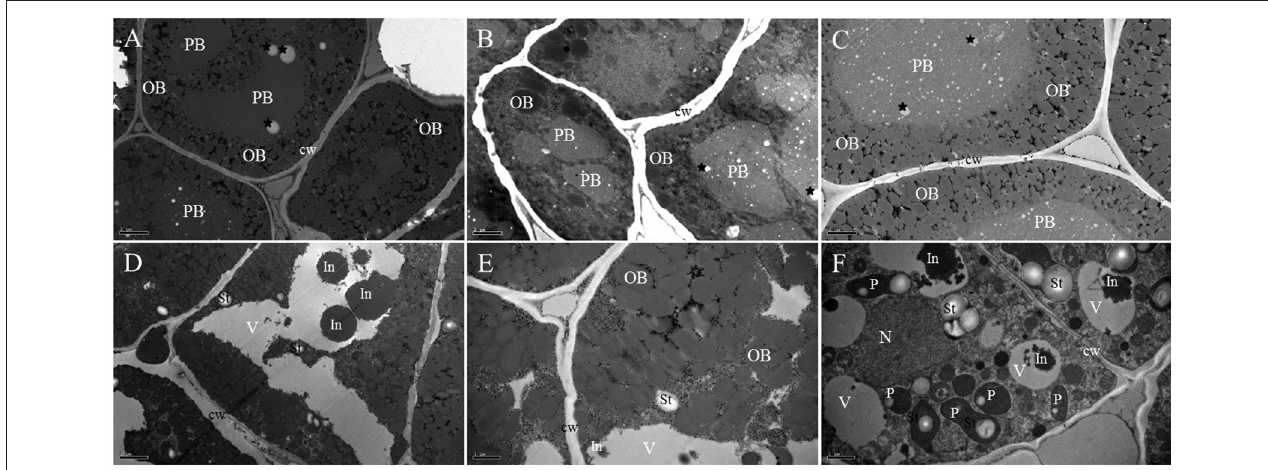
FIGURE 2 | TEM study of cotyledons during imbibition and seedling establishment. (A) Dry mature seed. Electron-dense protein body (PB) with a homogenous matrix embedded in a cytoplasm, densely populated by small and less electron-dense OBs. Electron-light, small, rounded areas are presented in the PB matrix (black stars). (B) Twelve hours of germination. The cytoplasm is filled up with electron-dense PBs and numerous electron-light OBs. The different size electron-light, rounded area now is all over its matrix (black stars). (C) Twenty-four hours of germination. Enlarged PBs with different degrees of electron density are surrounded by OBs in close contact. The presence of electron-light, rounded area through its matrix (black stars) still can be seen. (D) Overall presentation of the 2 days of germination. The PB compartment is now similar to a vacuole (V) with a low electron density lumen that contains irregular electron-dense inclusions (In); in the surrounding cytoplasm, minute OBs and starch grains (St) are present. (E) Enlarged presentation of the 2 days of germination. The gap between the OBs is increased and boundaries of the OBs become blurred. Some cytoplasmic-like structures appear in the space between the OBs. (F) Three days of germination. The vacuolar compartment (V) with a low electron density lumen contains irregular, electron-dense inclusions (In); in the peripheral cytoplasm, developing plastids (P) with inner membrane system and starch grains (St) are present. A nearly rounded nucleus (N) with condensed chromatin is attached to the nuclear envelope. PB, protein body; OB, oil body; V, vacuole; St, starch grains; P, plastids; cw, cell wall. Bar (A–D) = 2 µ m. Bar (E,F) = 1 µ